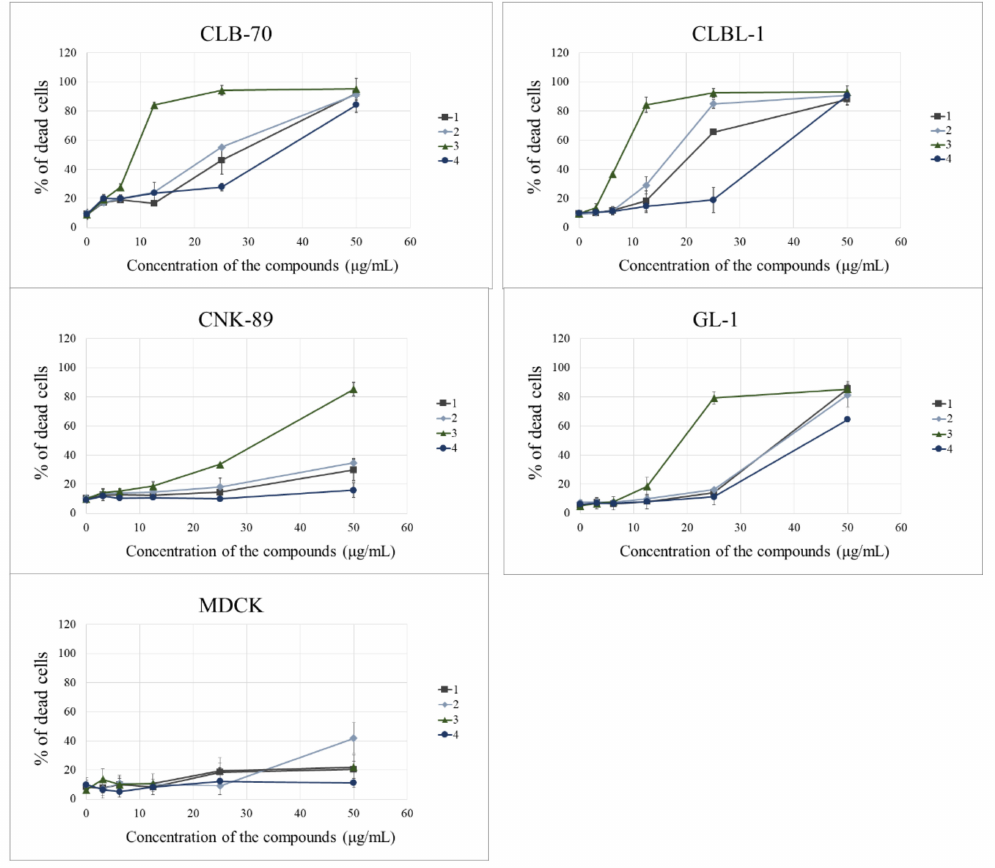
Figure 2. Concentration-dependent curves presenting the effects of the tested flavanone-derived γ -oxa- ε -lactones on the viability of canine cancer cell lines (CLB-70, CLBL-1, CNK-89 and GL-1) and noncancerous canine cell line (MDCK) after 48 h of incubation with different concentrations of individual lactones (3.125, 6.25, 12.5, 25 and 50 µ g/mL). The values are means from three independent experiments. Last picture shows statistical differences in IC 50 ( µ g/mL concentration of the tested compound that inhibits proliferation of 50% of cells) for all tested compounds in each cell line, necessary to compare how the activity of the individual derivatives differs. The results are presented as mean ± standard deviation (SD) of three separate experiments with three wells each. Results were analyzed using one-way ANOVA followed by Tukey’s multiple comparison test. Values without common letters (a, b, c) in the superscript differ statistically ( p < 0.05). N.A.—not